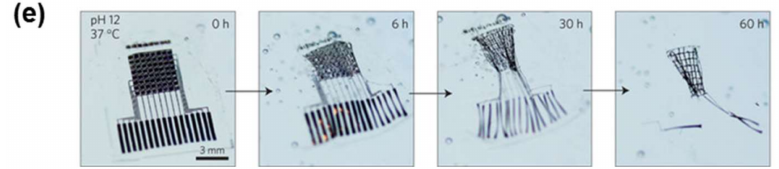
Figure 6. ( a ) Bioresorbable interfaces between intracranial sensors and external wireless data- communication modules with percutaneous wiring. ( 1 ) Image of bioresorbable pressure and temperature sensors integrated with dissolvable metal interconnects; ( 2 ) Diagram of a bioresorbable sensor system in the intracranial space of a rat; ( 3 ) Demonstrations of an implanted bioresorbable sensor in a rat and ( 4 ) sutured individual; ( 5 ) Healthy, freely moving rat equipped with a complete, biodegradable wireless intracranial sensor system. Reprinted with permission from Ref. [114], Copyright (2016), Springer Nature; ( b ) Images collected at several stages of accelerated dissolution of a bioresorbable pressure sensor upon insertion into an aqueous buffer solution (pH 12). Reprinted with permission from Ref. [114], Copyright (2016), Springer Nature; ( c ) Bioresorbable, actively multiplexed neural electrode array in an exploded-view rendering. Reprinted with permission from Ref. [115], Copyright (2016), Springer Nature; ( d ) Optical micrograph images of a pair of unit cells at various stages of fabrication ( left ) and a picture of a complete system ( right ). Reprinted with permission from Ref. [115], Copyright (2016), Springer Nature; ( e ) Images